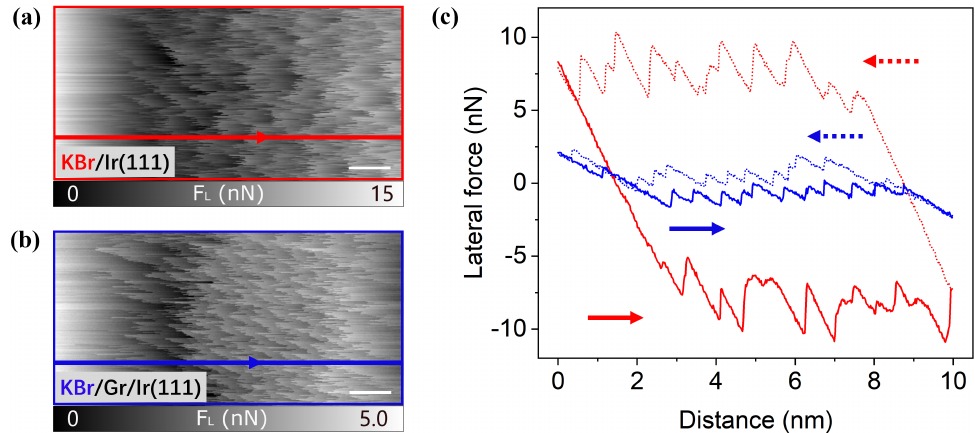
Figure 3. Frictional images (forward direction of the two KBr structures at a normal load of F n = 5nN: ( a ) KBr/Ir(111), ( b ) KBr/Gr/Ir(111). Scale bar: 1nm. The corresponding friction loops of a single line marked in both images are presented in ( c ).